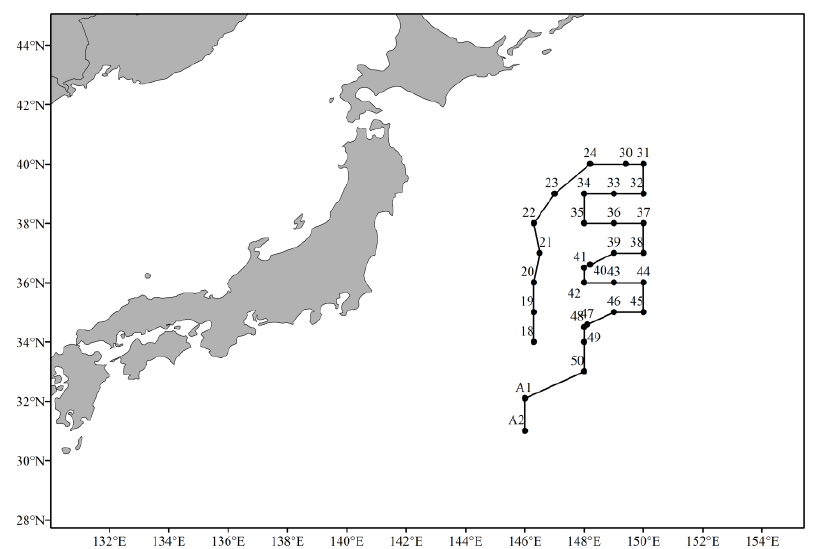
Figure 1. The distribution of 30 acoustic stations during the 2019 Songhangsurvey at the Northwest Pacific